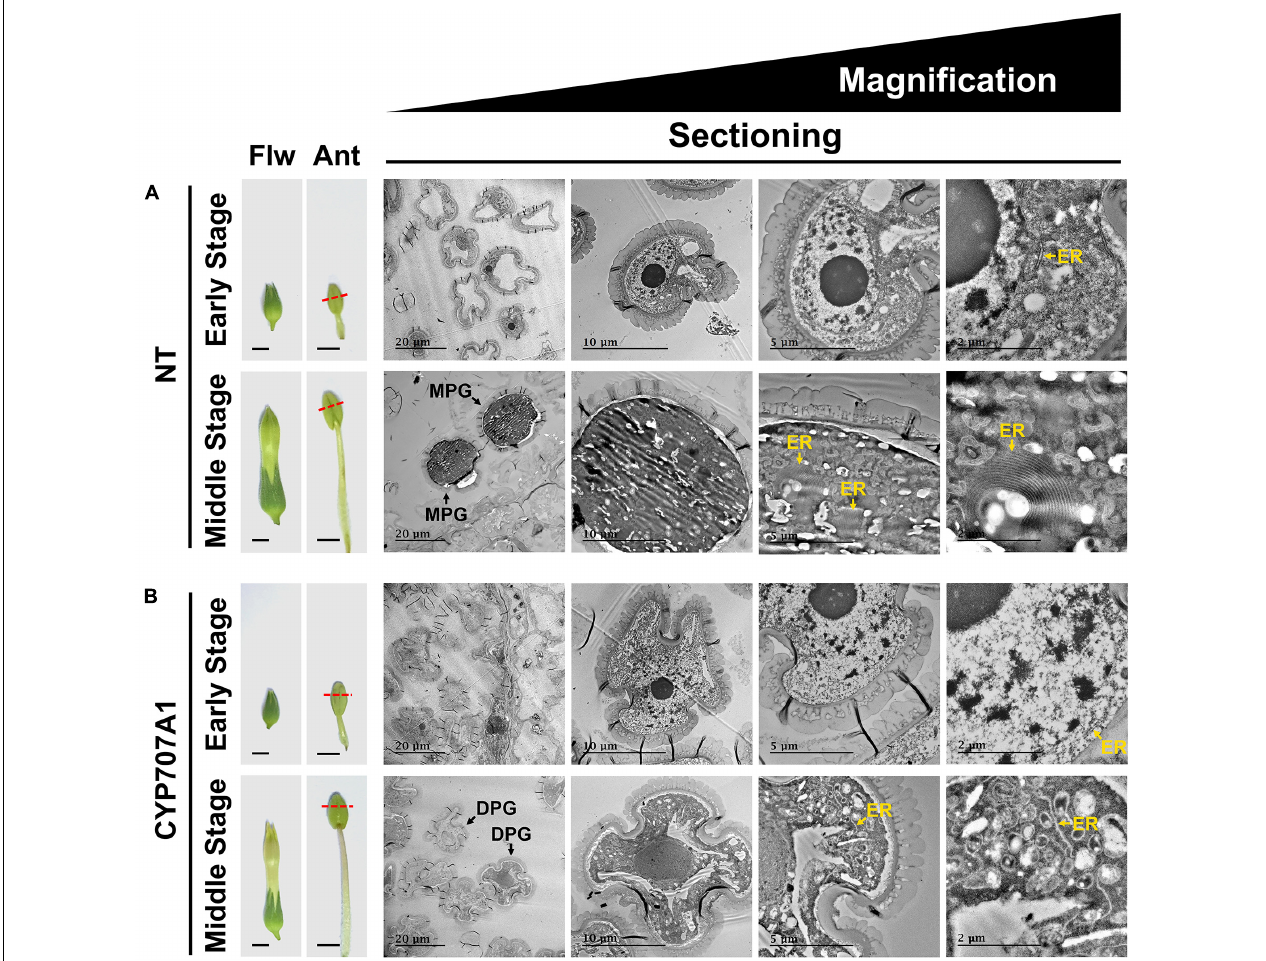
FIGURE 6 | Suppressed pollen maturation in 35S:CaCYP707A1 plants. (Left) Images of flowers (Flw) and anthers (Ant), and (right) ultrastructure of the pollen formed in NT (A) and 35S:CaCYP707A1 (B) plants as shown by ultra-thin sections and TEM. CYP707A1 indicates 35S:CaCYP707A1 transgenic plants (line #1), and red dashed lines mark the longitudinal positions from which the slices were obtained. Yellow arrows indicate the ER membrane. Ant, anther; DPG, degenerated pollen grain; ER, endoplasmic reticulum; Flw, flower; MPG, mature pollen grain. Scale bars = 0.5 cm in flower; 0.2 cm in anther; and (left to right) 20, 10, 5, and 2 µ m in TEM images. Two individuals of the indicated plants were analyzed, and the experiments were performed two times with similar